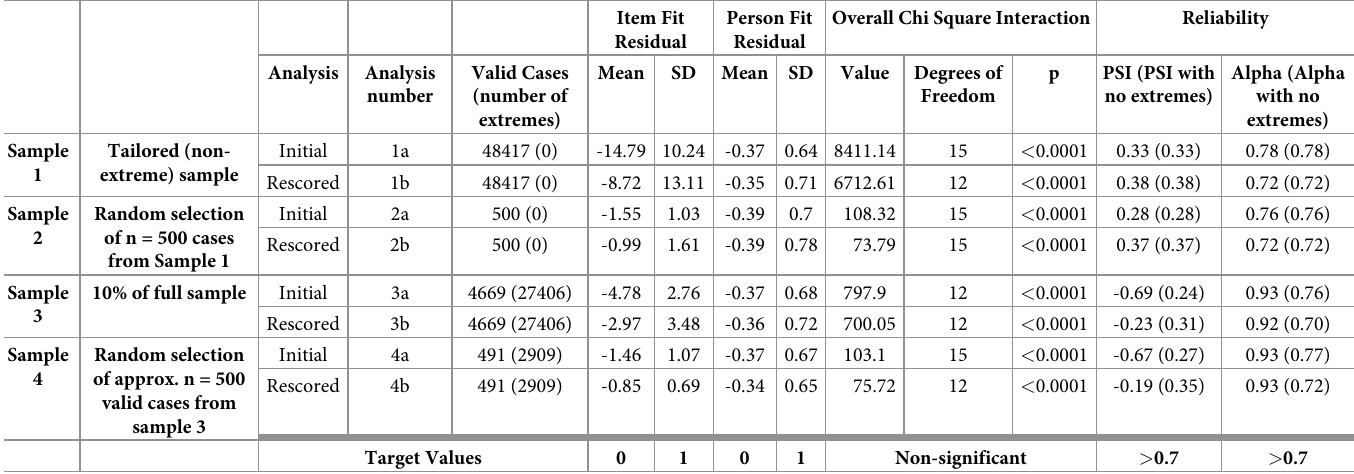
Table 3. Summary Rasch scale fit statistics across four GCS samples, pre-and